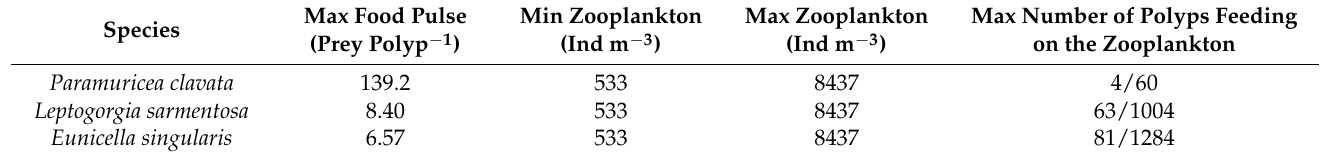
Table 8. Impact on the zooplankton (water near bottom seston) of the three studied species. The number of polyps feeding on zooplankton is the ratio between the zooplankters in the short time cycle (minimum and maximum) found in one cubic meter (m 3 ) of sea water and the maximum prey found in the polyps of each species (calculations made per day). Max Food Species